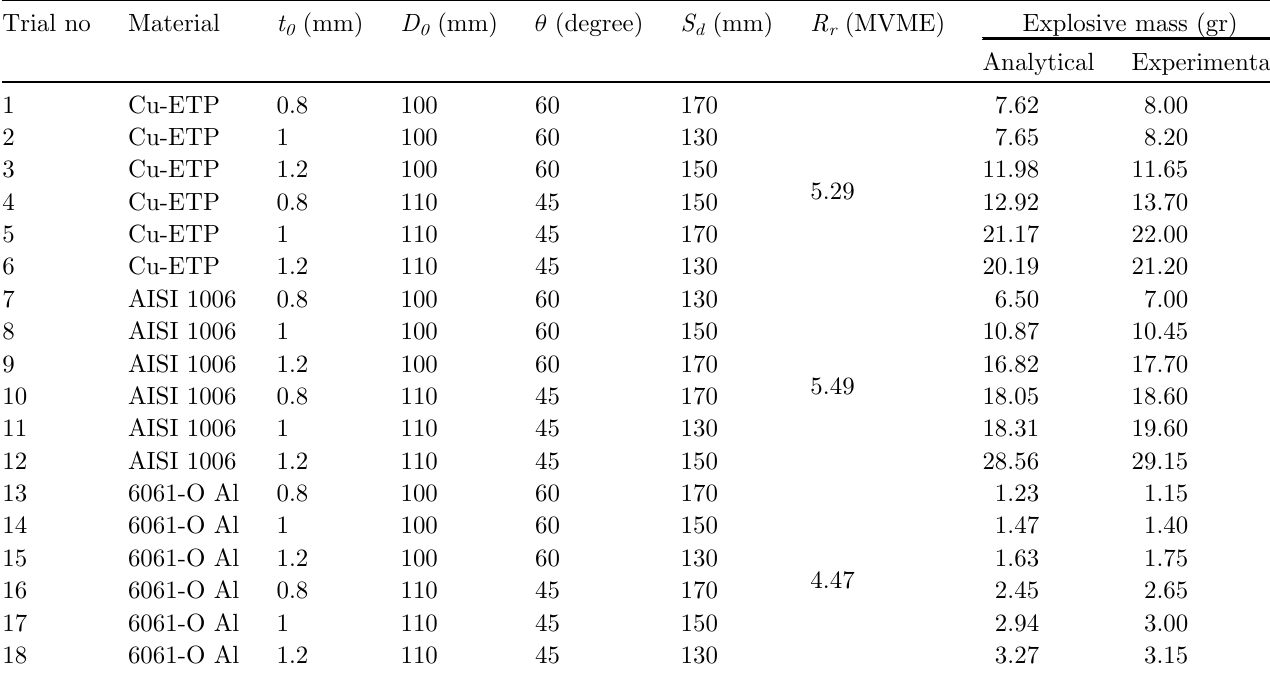
: Analytical and experimental results of explosive mass. r